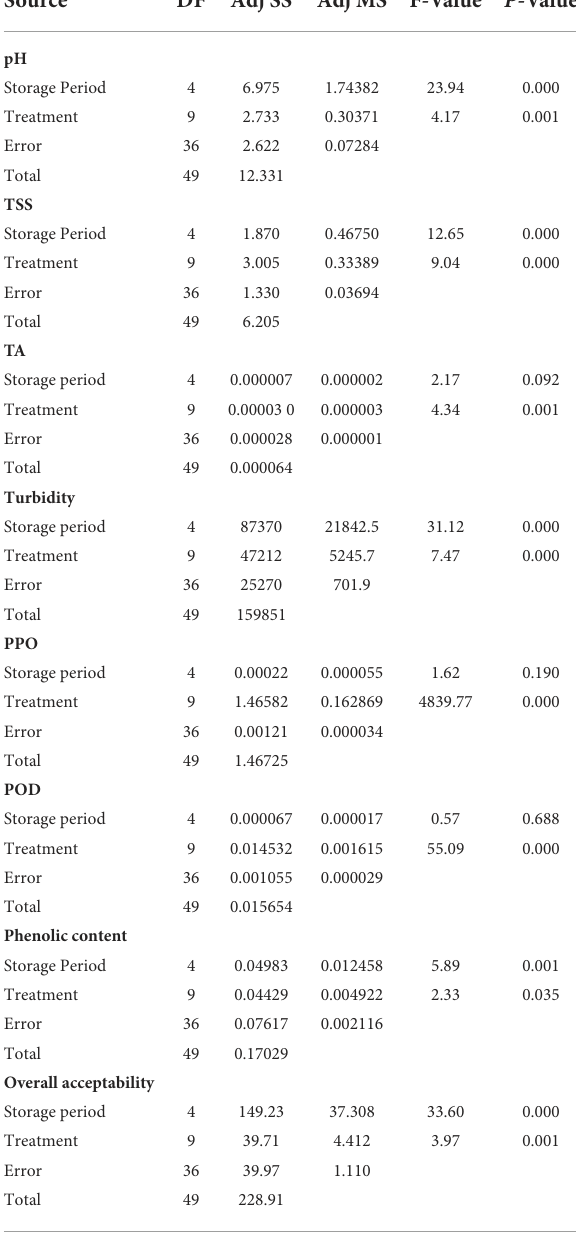
TABLE 2 Analysis of variance (ANOVA) to understand the statistical effect of storage period and treatments on the quality of tender coconut